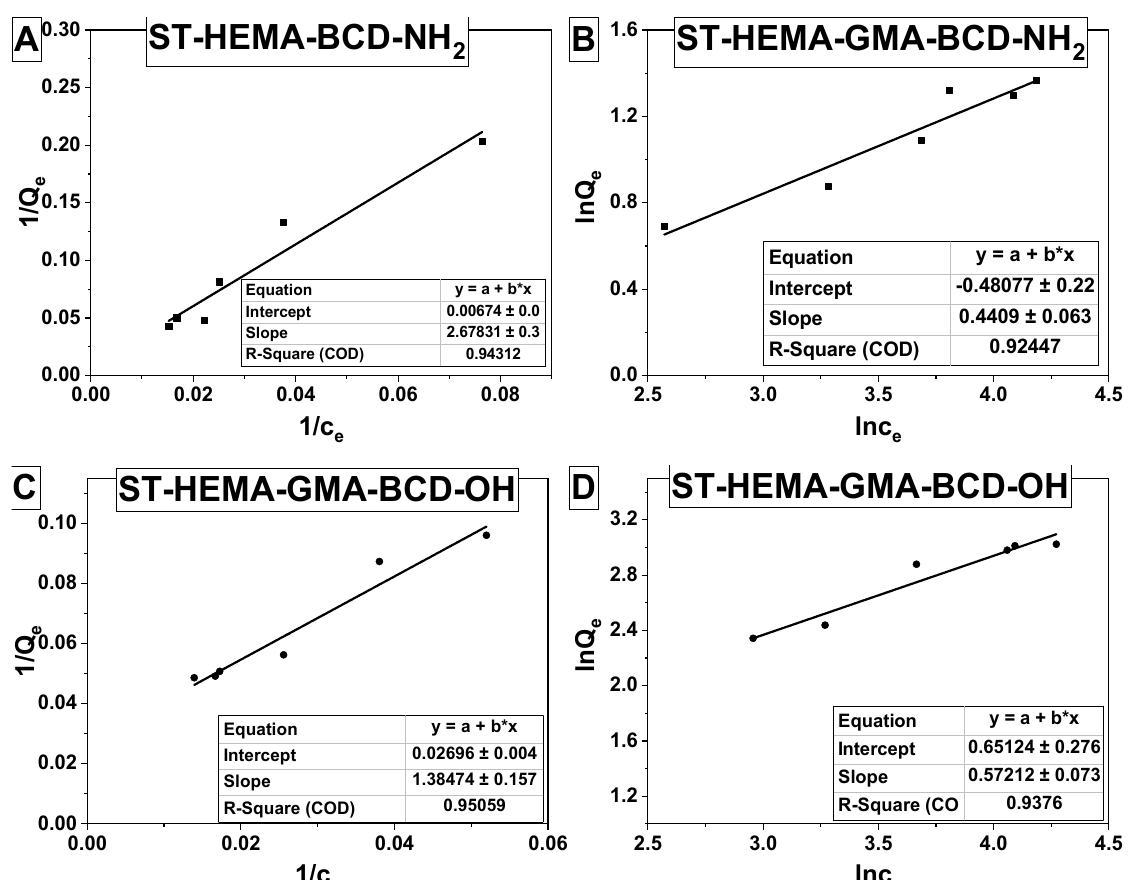
Figure 5. ( A , C ) Langmuir plots illustrating the linear dependences of 1/Q e on 1/c e , and ( B , D ) Freundlich plot illustrating the linear dependences of lnQ e on lnc e for adsorption of bisphenol A by ST-HEMA-BCD-NH 2 and ST-HEMA-BCD-OH, respectively. Table 2. Isotherm parameters for the adsorption of bisphenol A by ST-HEMA-GMA-BCD-NH 2 and ST-HEMA-GMA-BCD-OH.